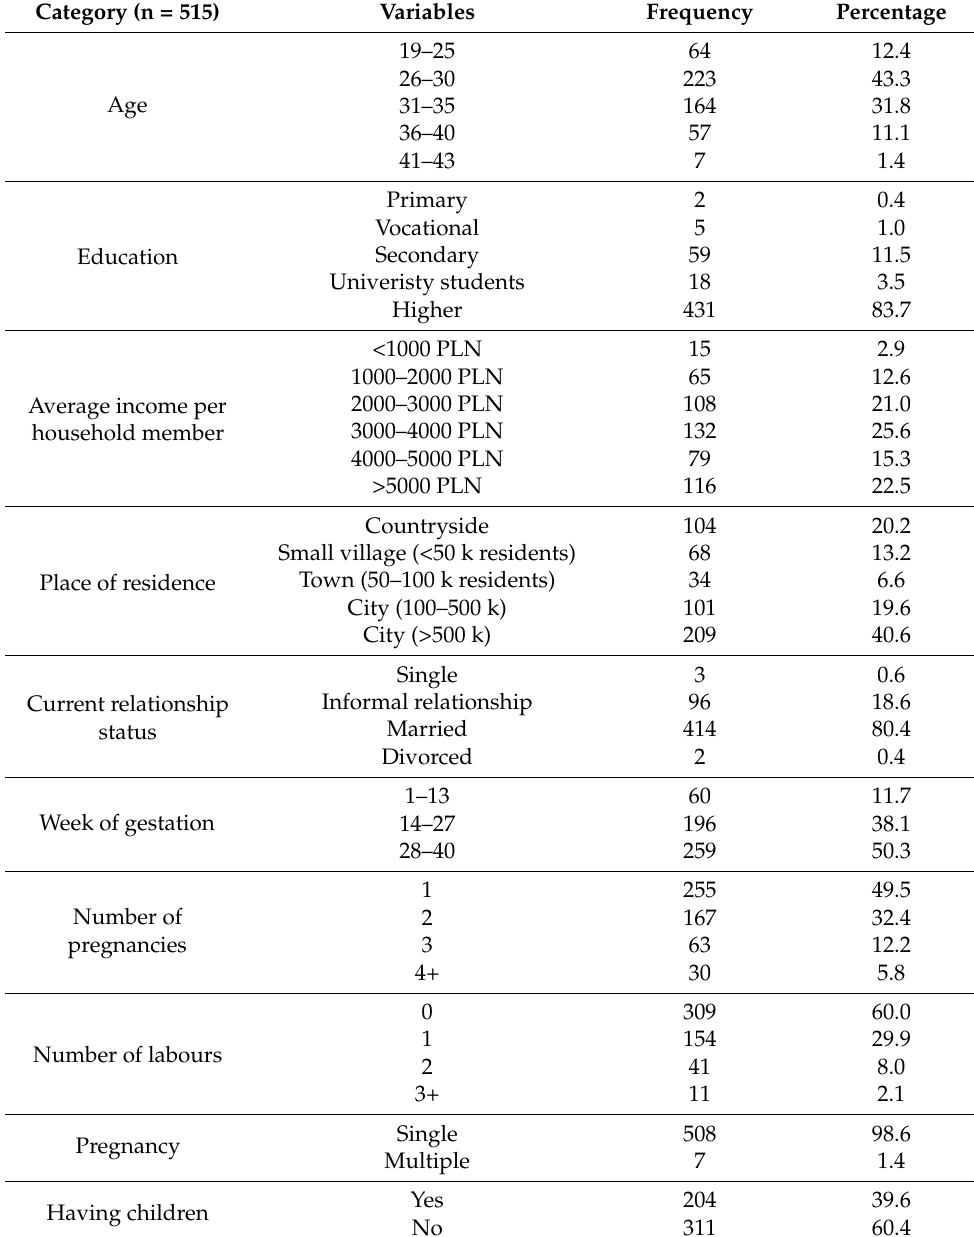
Table 1. Sociodemographic and obstetric characteristics of participants.